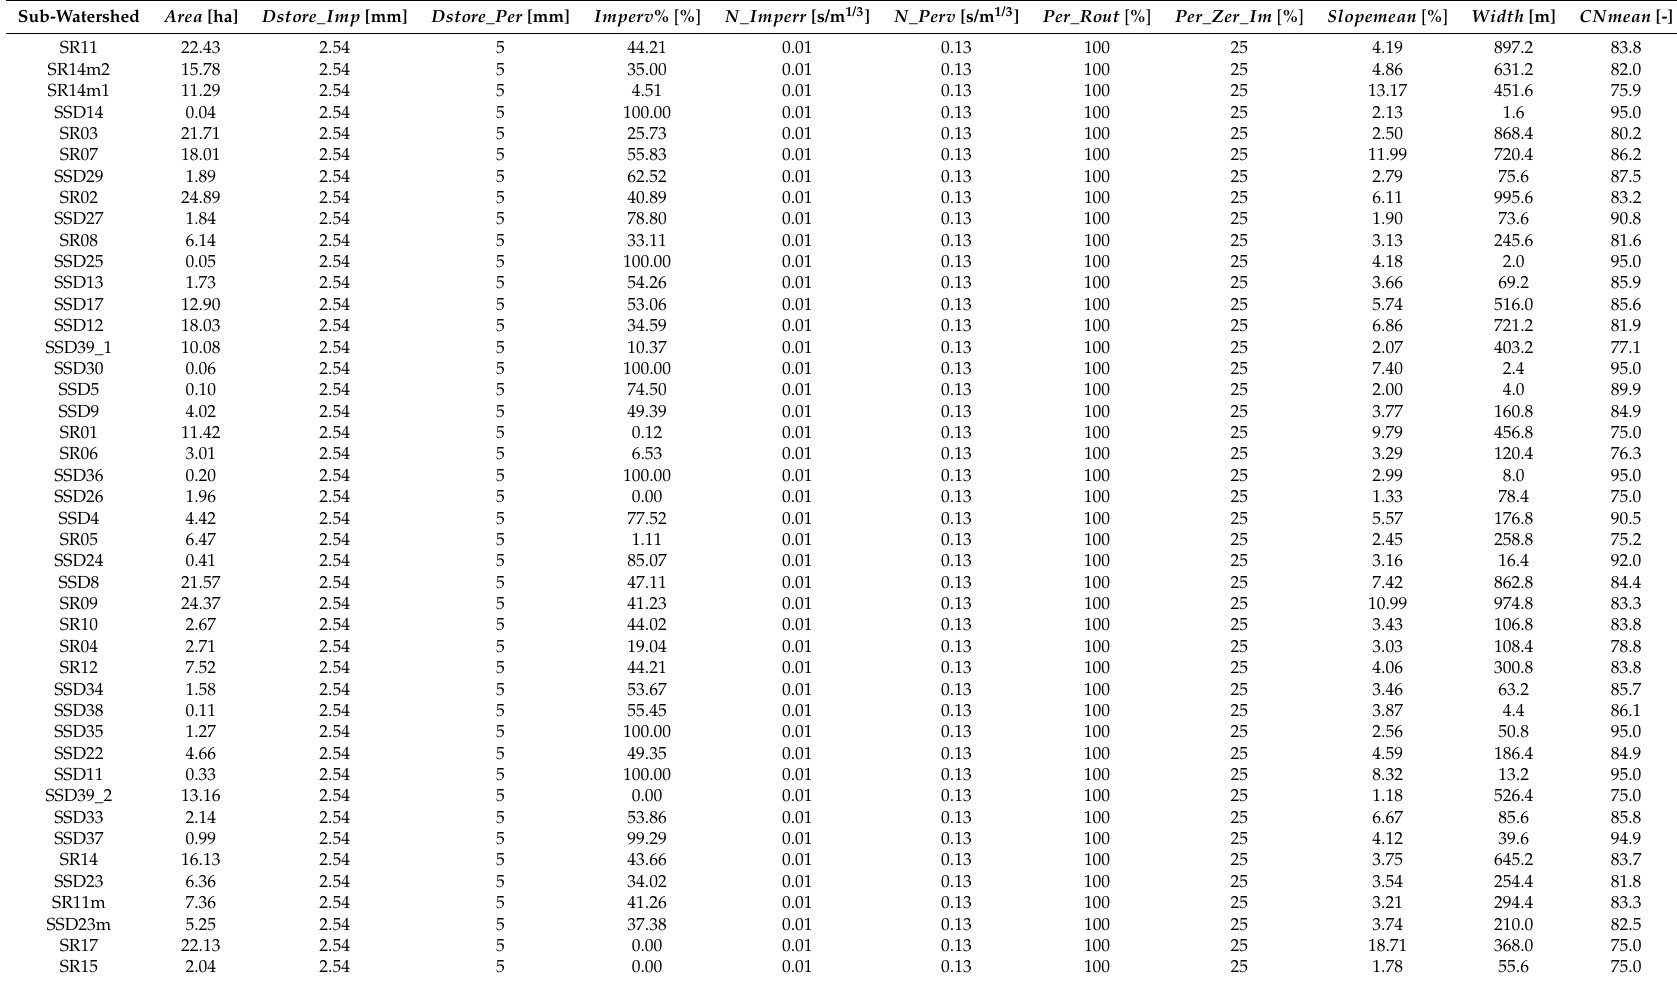
Table 3. Input parameters of SWMM model for the 44 urban HHU shown in Figure